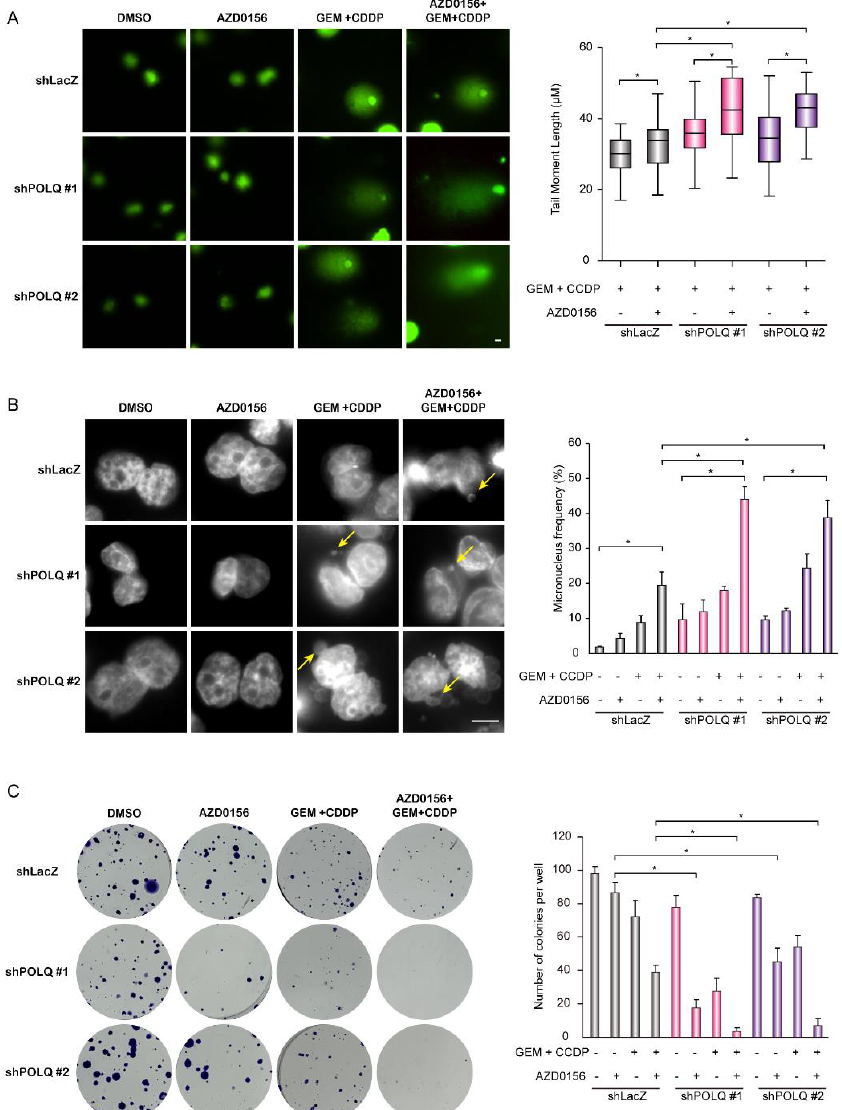
Figure 7. AZD0156 and DNA polymerase θ depletion leads to DNA damage accumulation and suppresses tumor growth. ( A ) The alkaline comet assay: TGBC-24TKB cells receiving shRNAs specific to DNA polymerase θ (shPOLQ) or LacZ (shLacZ) were treated with 0.5 μM GEM and 5 μM CDDP, followed by 5 μM AZD0156 for another 4 h before a comet assay. Left: the representative comet images are shown. Right, the quantitative data on the length of the tail movement. The values (means ± SD) are from two independent experiments; * p < 0.05 by Student’s t -test ( n = 50). ( B ) Micronucleus frequency in TGBC-24TKB cells receiving shRNAs specific to DNA polymerase θ (shPOLQ) or LacZ (shLacZ). The cells were treated with 0.5 μM GEM and 5 μM CDDP for 24 h, and were then cultured in the absence or presence of 2.5 μM AZD0156 for another 24 h. Left: representative images of the micronucleus (arrows) are shown. Right, the quantitative data of the percentage of micronuclei. The values (means ± SD) are from two independent experiments; * p < 0.05 by Student’s t -test ( n = 100). ( C ) The colony formation assay was performed in TGBC-24TKB cells receiving shRNAs specific to DNA polymerase θ (shPOLQ) or LacZ (shLacZ). The cells (400 cells/well) were seeded in a six-well plate for 14 days, cultured in the absence or presence of 0.5 μM GEM and 5 μM CCDP for 24 h, and then cultured in the absence or presence of 1 μM AZD0156 for another seven days. Left: representative images are shown. Right: the values (means ± SD) are from two independent experiments; * p < 0.05 by Student’s t -test.